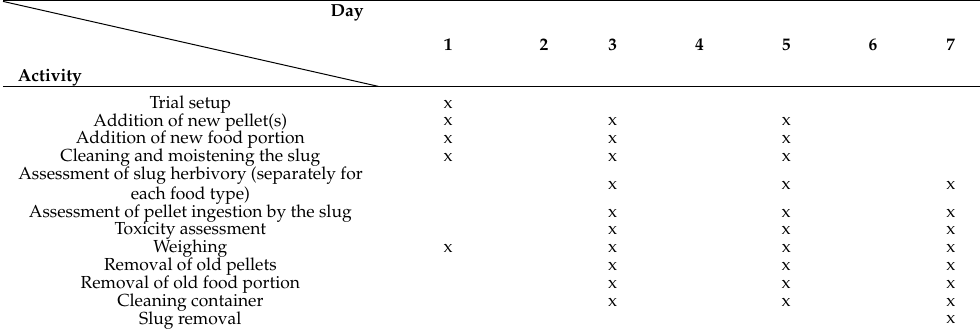
Table 2. Timetable of activities and measurements for the experiment during one